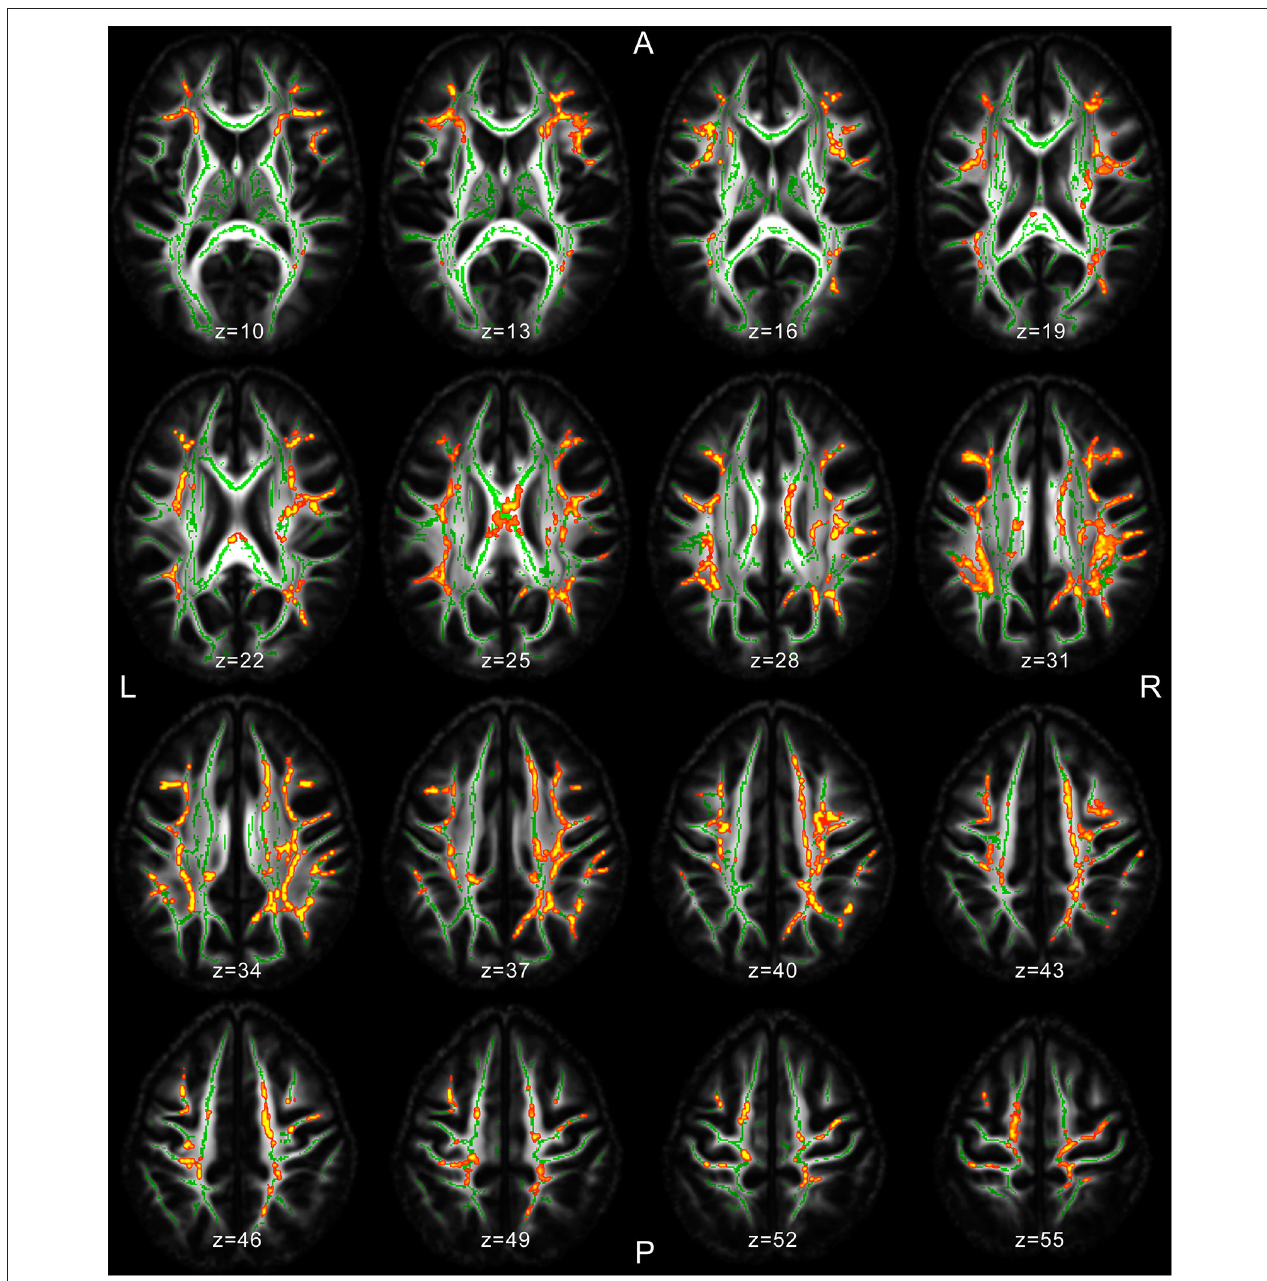
FIGURE 1 | MRI images of significant TBSS clusters in patients with JME compared to healthy controls superimposed to the skeleton (light green).